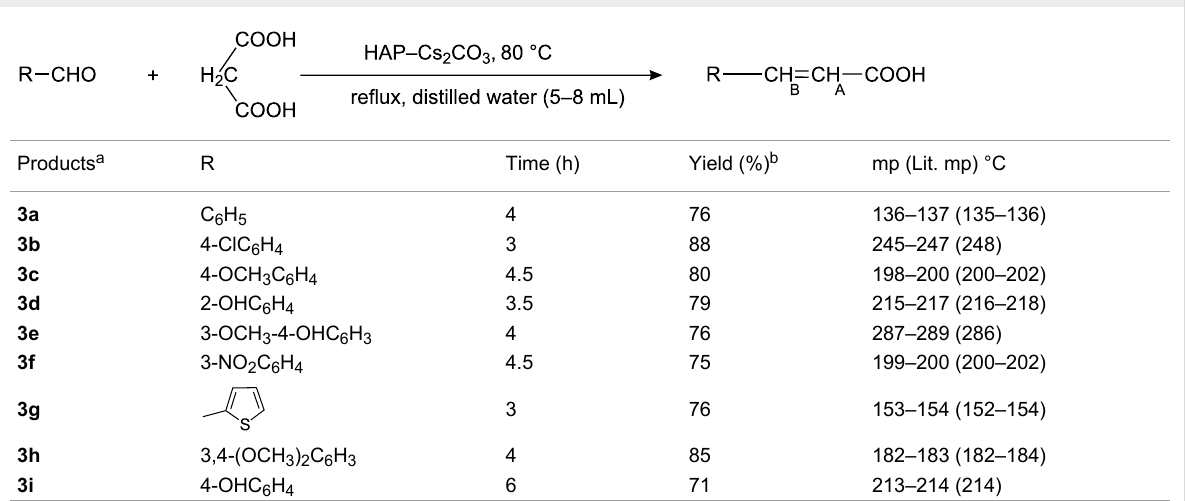
Table 2: HAP–Cs 2 CO 3 catalysed Knoevenagel condensation between aromatic aldehydes and malonic acid at 80 °C using water as solvent.